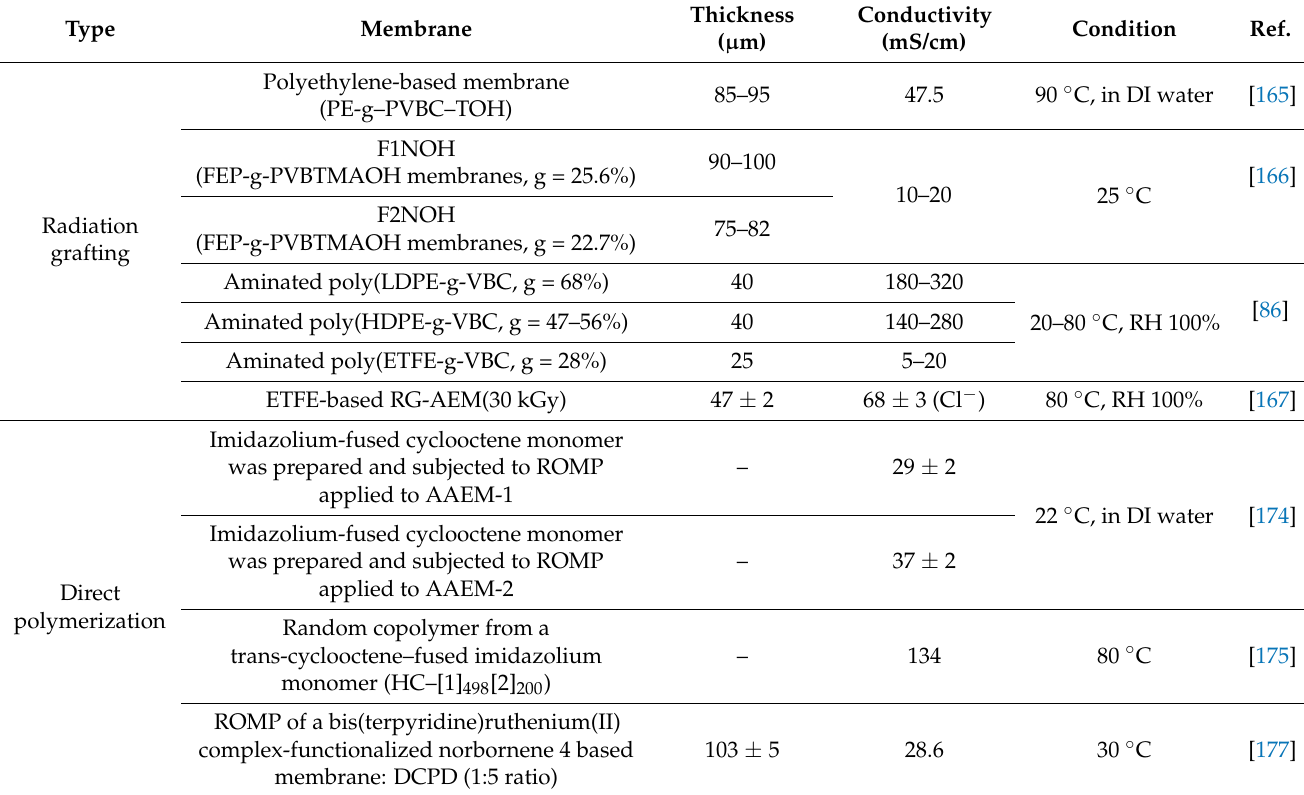
Table 9. Ionic conductivity of polyolefin-based